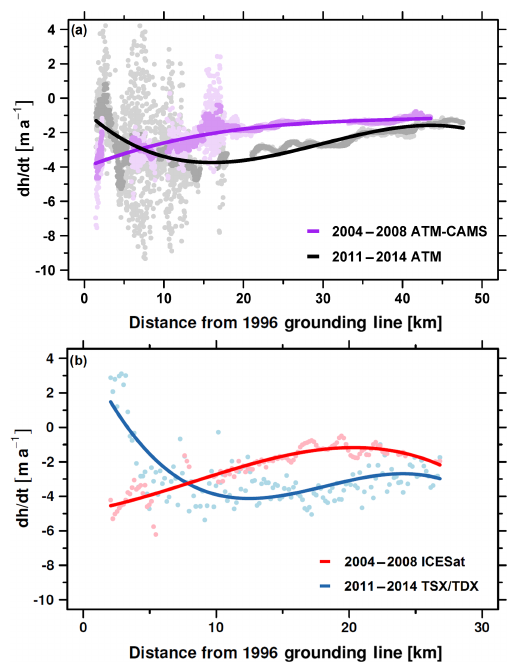
Figure 5. (a) Elevation change rates on Fleming Glacier 2004–2008 and 2011–2014 plotted against distance from the 1996 grounding line. Light purple dots: change rates from PIB ATM and CAMS li- dar measurements in 2004 and 2008. Purple dots: median filtered elevation change rates 2004–2008. Light grey dots: change rates from OIB ATM lidar measurements in 2011 and 2014. Dark grey dots: median filtered elevation change rates 2004–2008. See Fig. 4 for flight path locations. Purple and black lines: cubic functions fitted to the median filtered elevation change rates. (b) Elevation change rates on Fleming Glacier 2004–2008 and 2011–2014 plot- ted against distance from the 1996 grounding line. Light red dots: change rates from ICESat measurements in 2004 and 2008. Light blue dots: change rates between 2011 and 2014, extracted from the TSX–TDX d h/ d t map along the 2008 ICESat track (see Fig. 4 for location). Red and blue lines: cubic functions fitted to both data